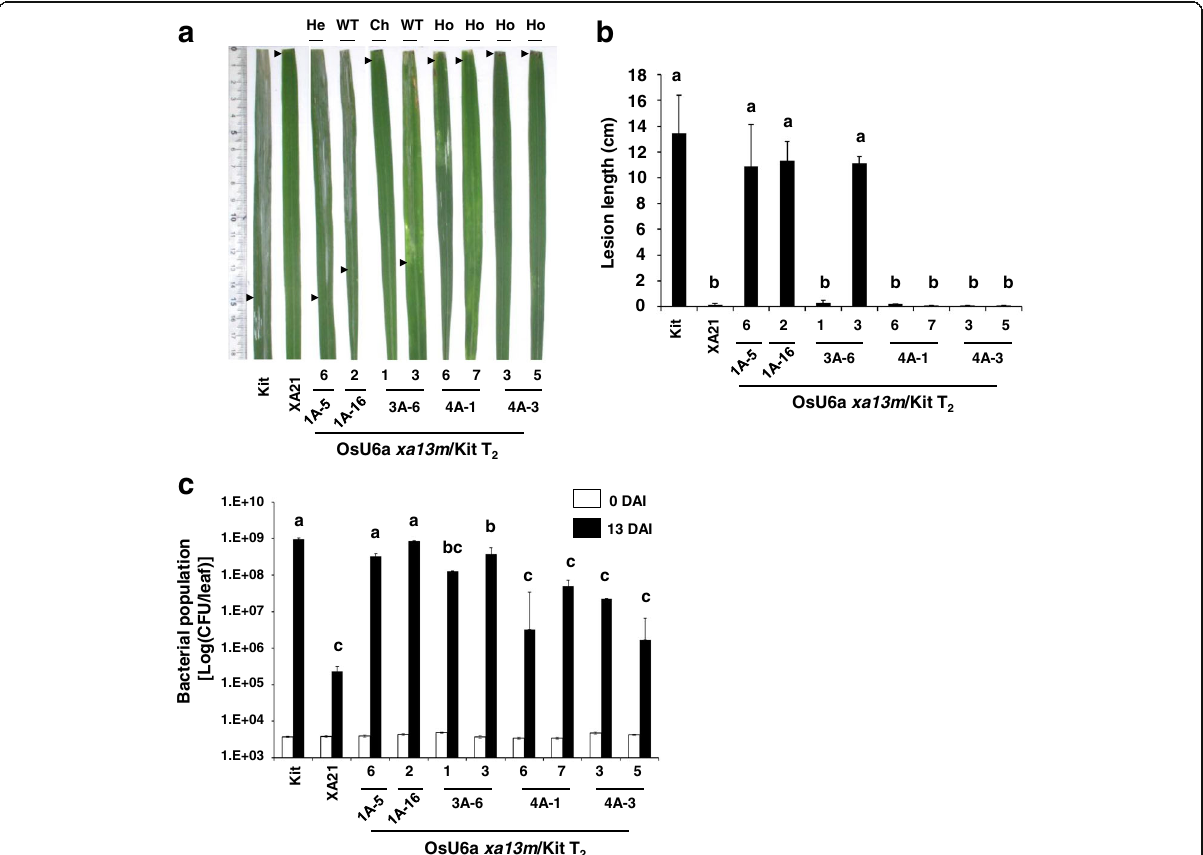
Fig. 5 Homozygous mutants in both Os8N3 alleles displayed enhanced resistance to Xoo . Transgenic Kitaake plants targeting xa13 (OsU6a xa13m / Kit T 2 ) display enhanced resistance to Xoo . a Inoculation results for mutant rice lines 12 DAI with Xoo . From left to right: Kitaake (Kit), transgenic line (XA21, 7A-8) carrying Xa21 driven by the ubiquitin promoter, and transgenic lines (OsU6a xa13m /Kit, T 2 ) carrying the OsU6a:: xa13m-sgRNA / pHAtc construct. Arrowheads indicated the end of the lesion. He; Heterozygous; WT; wild type: Ch; chimeric: Ho; homozygous. b Lesion lengths measured 12 DAI in Kitaake, XA21, and OsU6a xa13m /Kit T 2 . Error bars in the graph represent standard error of at least three leaves from each plant. Letters indicate a significant difference at P < 0.050 by Tukey ’ s HSD test. c Bacterial population in Kitaake, XA21, and OsU6a xa13m /Kit T 2 plants 0 and 12 DAI, determined by the number of CFU per inoculated leaf. Error bars represent standard deviation from at least three technical replicates. Letters indicate a significant difference at P < 0.050 by Tukey ’ s HSD test